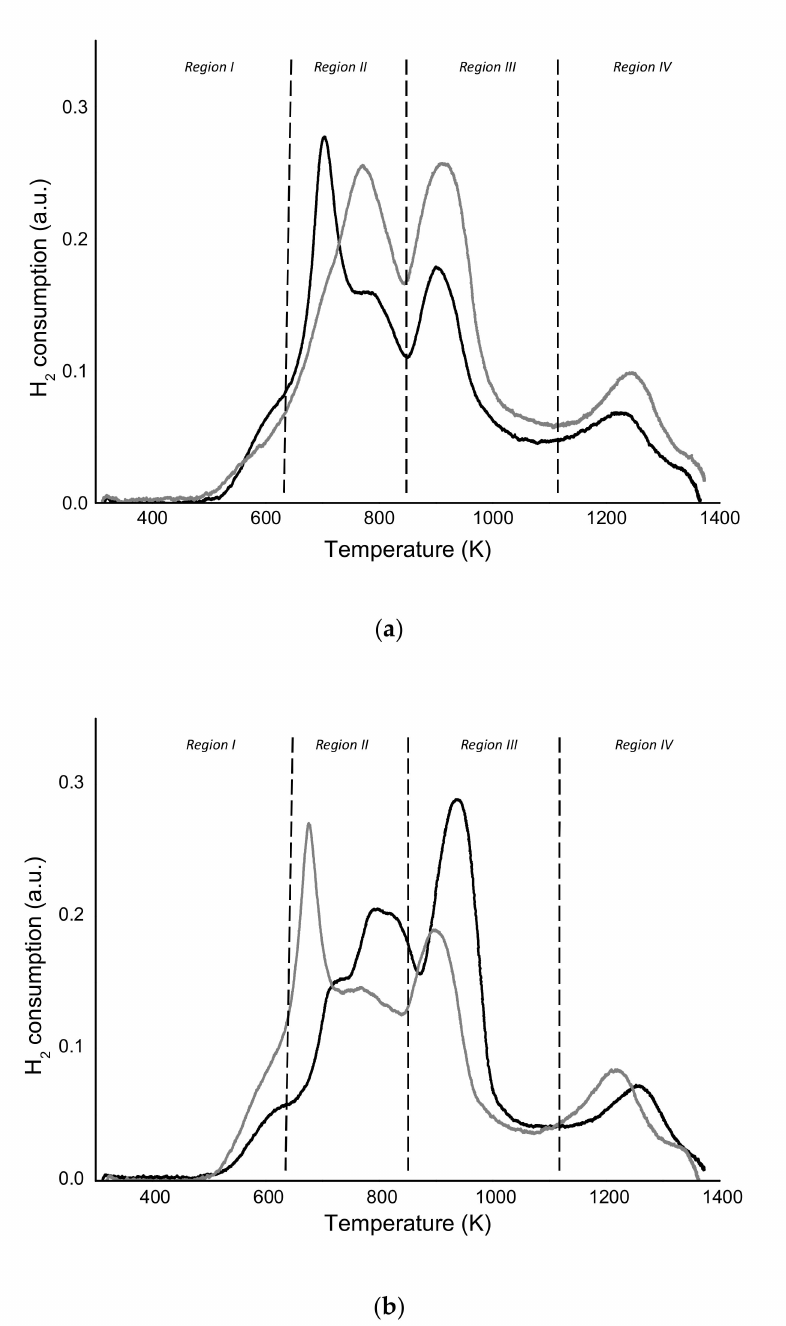
Figure 3. H 2 -TPR profiles for the Mo/ZSM-5 catalyst prepared by incipient wetness, MoZ5-IW-SC (black line), and MoZ5-IW-DC (grey line) ( a ) and by solid state reaction, MoZ5-SSR-SC (black line) and MoZ5-SSR-DC (grey line) ( b